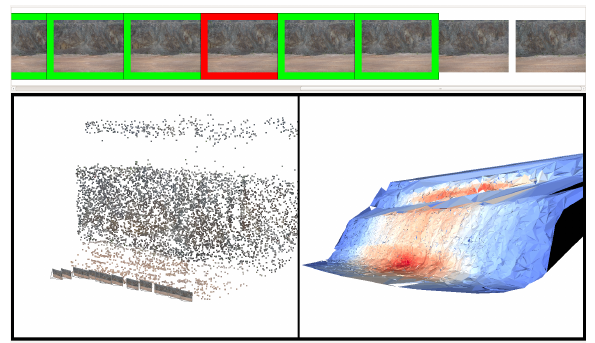
Figure 8: Visualization of ground resolution using an online Structure-from-Motion system to assess reconstruction accuracy and scene coverage during image acquisition.